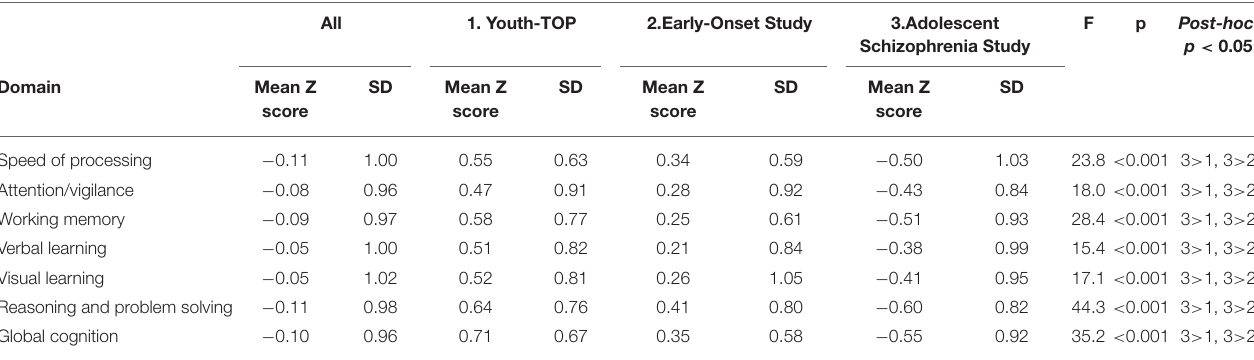
TABLE 2 | Cognition across cohorts.